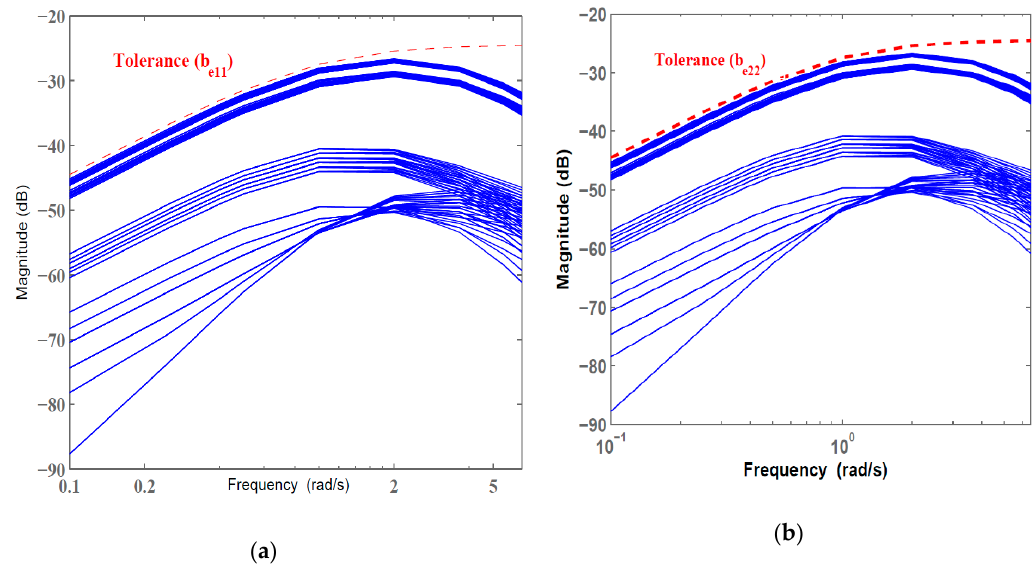
Figure 7. Frequency domain validation of the proposed design for the model matching specification. The plots show the error tolerances B e (dashed red line) and the closed loop magnitude (solid line) of diagonal element over all the 6561 plants for ( a ) channel-11 (lower magnet), and ( b ) channel-22 (upper magnet).